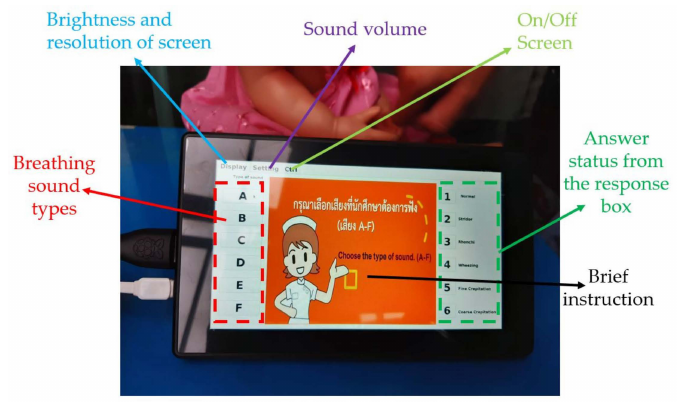
Figure 8. A display